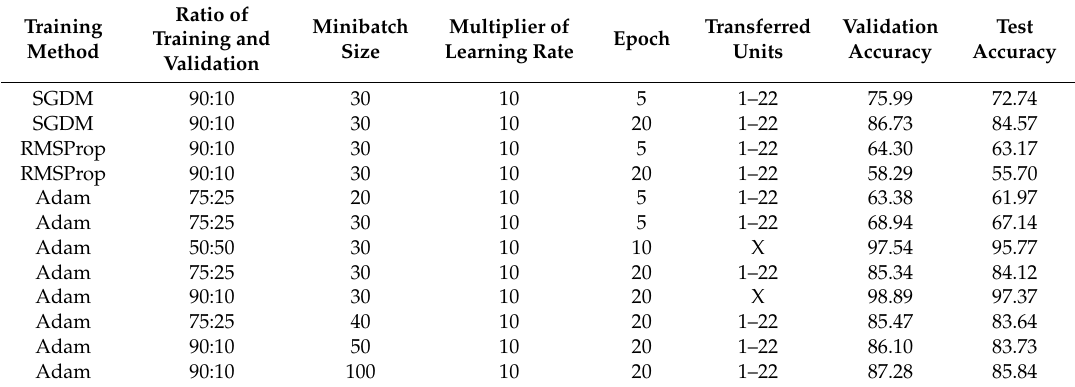
Table 2. Performance of AlexNet on PTB-ECG.